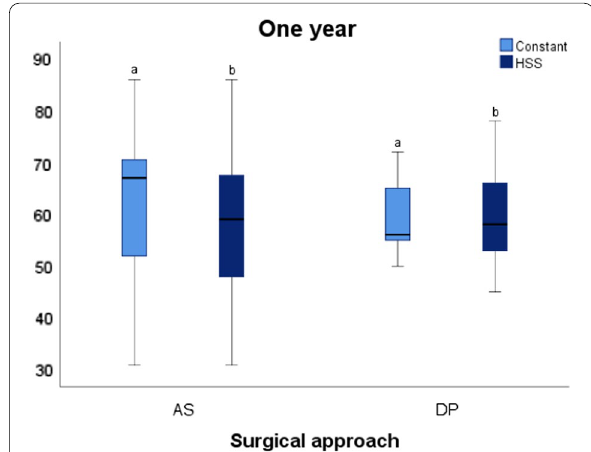
Fig. 1 Boxplot charts where we can observe function (according to Constant and HSS) in both approaches used 1 year after surgery. Same letters indicate no statistically significant differences between them ( p < 0.05, a and b ). AS anterosuperior, DP deltopectoral